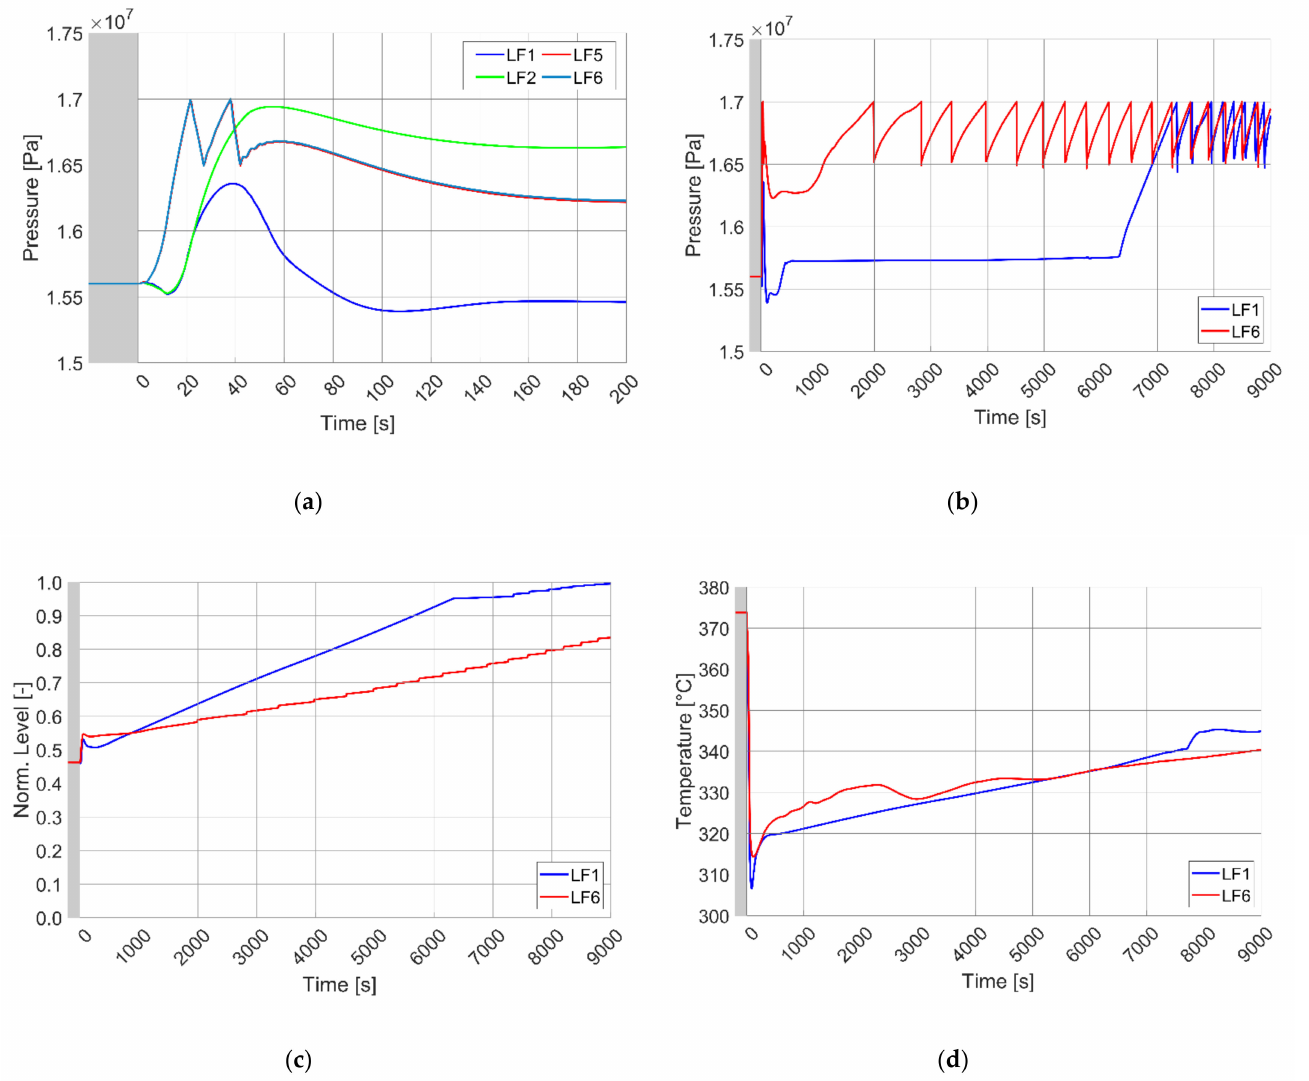
Figure 8. Comparison between LF1 and LF6 transients: ( a ) Pressure in FW PHTS (early time); ( b ) Pressure in FW PHTS (full range); ( c ) Collapsed level in FW pressurizer (normalized, full range); ( d ) Maximum Eurofer temperature in FW component (full